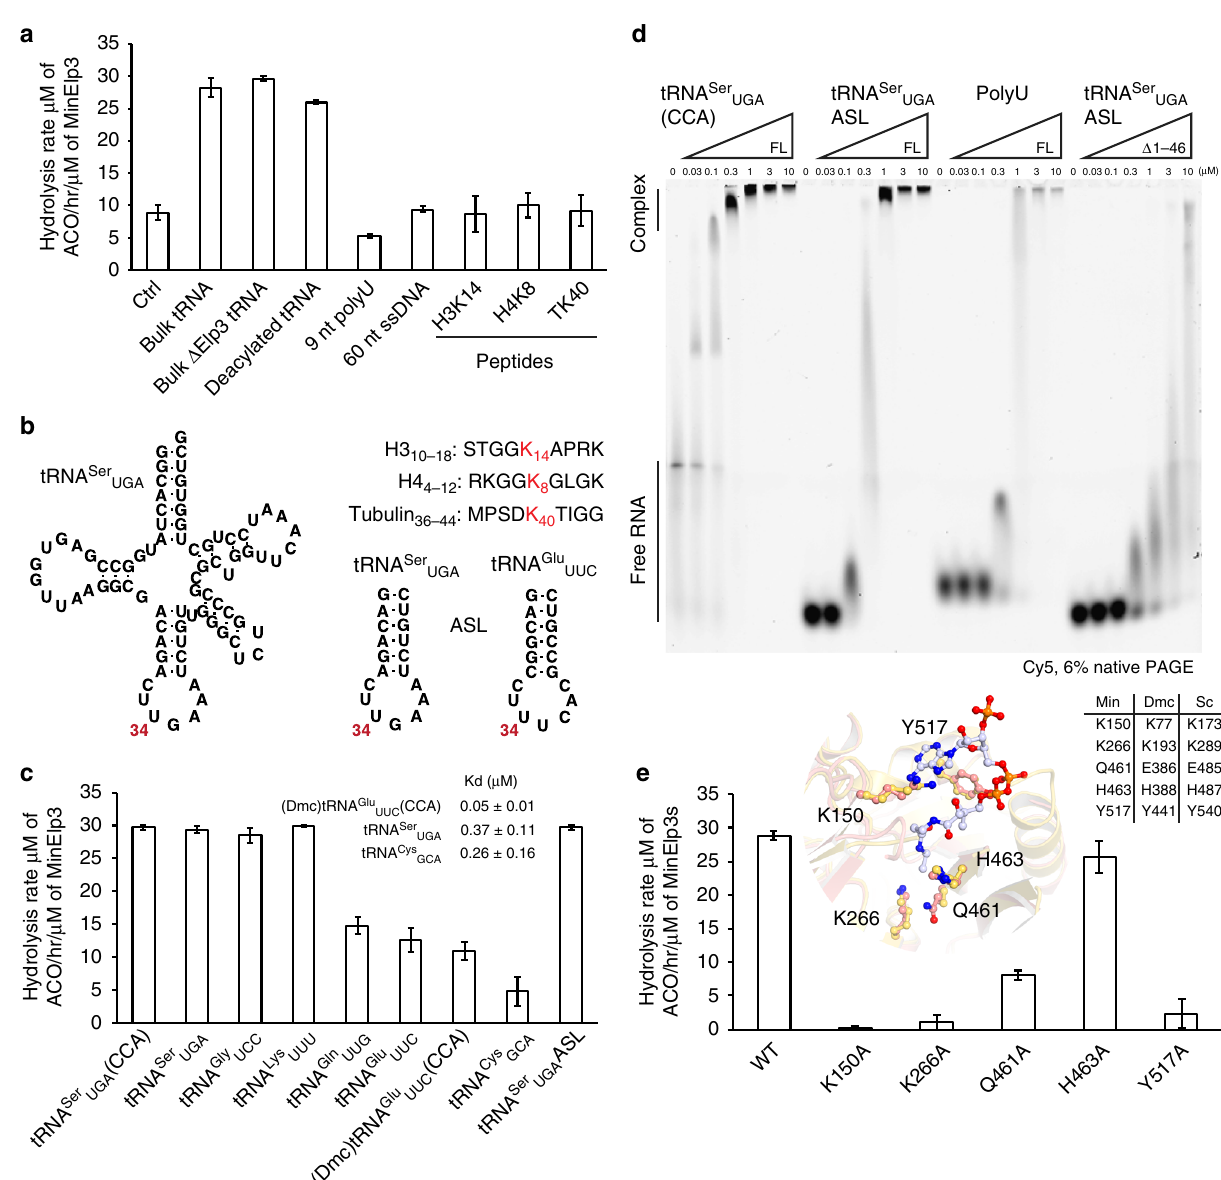
Fig. 4 Substrate speci fi city feature of MinElp3 to activate acetyl-CoA hydrolysis. a Acetyl-CoA hydrolysis reactions of MinElp3 in the presence of different substrates, n = 3. b Chemical structure illustrations of tRNA and ASLs. Sequences of used peptides are given and modi fi able lysine (K) residues are highlighted. c Acetyl-CoA hydrolysis reactions of MinElp3 in the presence of different tRNA substrates, n = 3 d EMSA analyses of MinElp3s binding to different nucleic acid substrates. Protein concentrations are given and positions of free tRNA and protein-tRNA complex are labeled. e Acetyl-CoA hydrolysis reactions of different MinElp3 point mutations in the presence of endogenous yeast bulk tRNA ( Δ elp3; UMY2916), n = 3. Superposition of highlighted residues in the acetyl-CoA binding pocket from MinElp3 (light pink) and DmcElp3 (yellow). DCA is shown in ball and sticks representation. The equivalent residue numbers in different Elp3s are indicated. Data represent mean ± SEM. Source data are provided as a Source Data fi